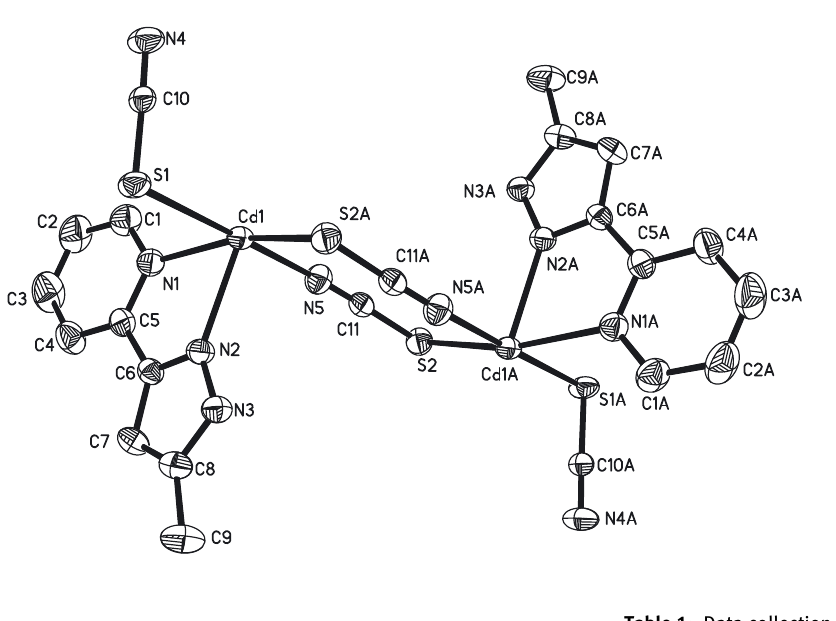
Table  : Data collection and